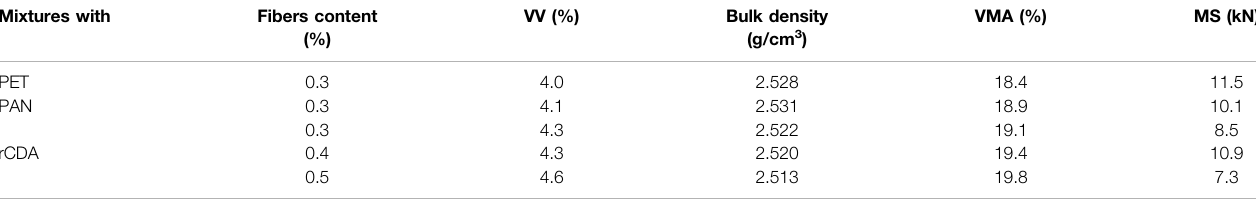
TABLE 3 | Marshall test results for the volumetric properties of specimens with asphalt content of 6.0%. Mixtures with Fibers content (%)